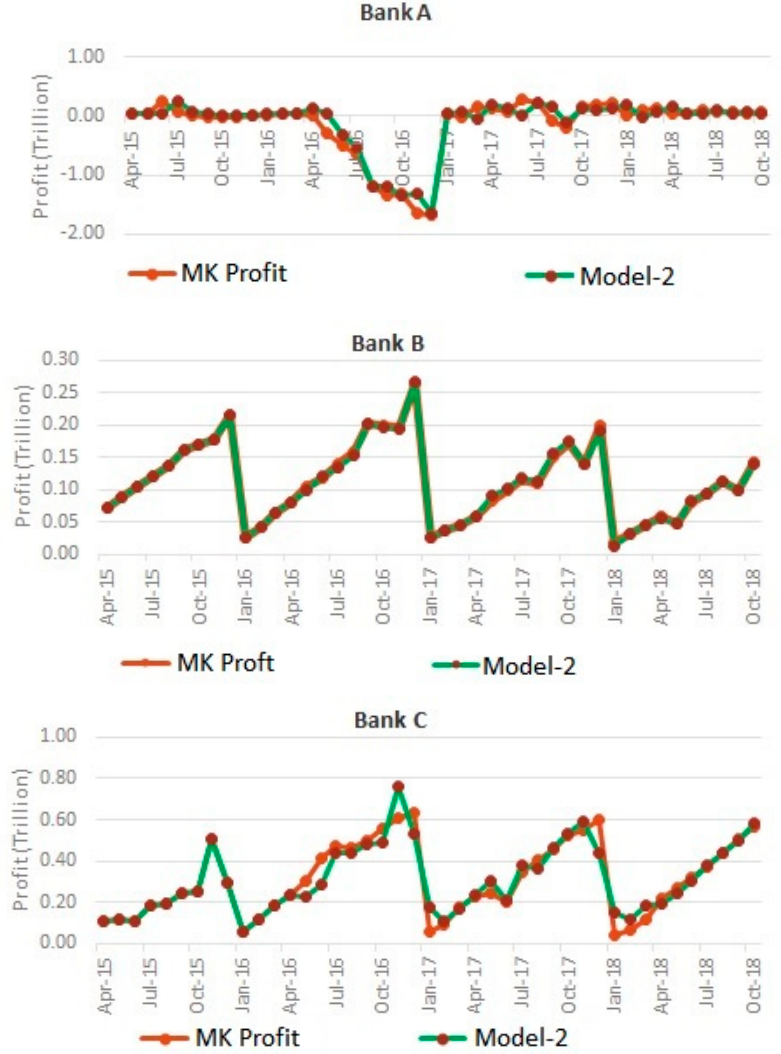
Figure A6. Estimated profits of Models-2 for each bank. Table A1. Models-2 forecast profit for Bank A in IDR million.